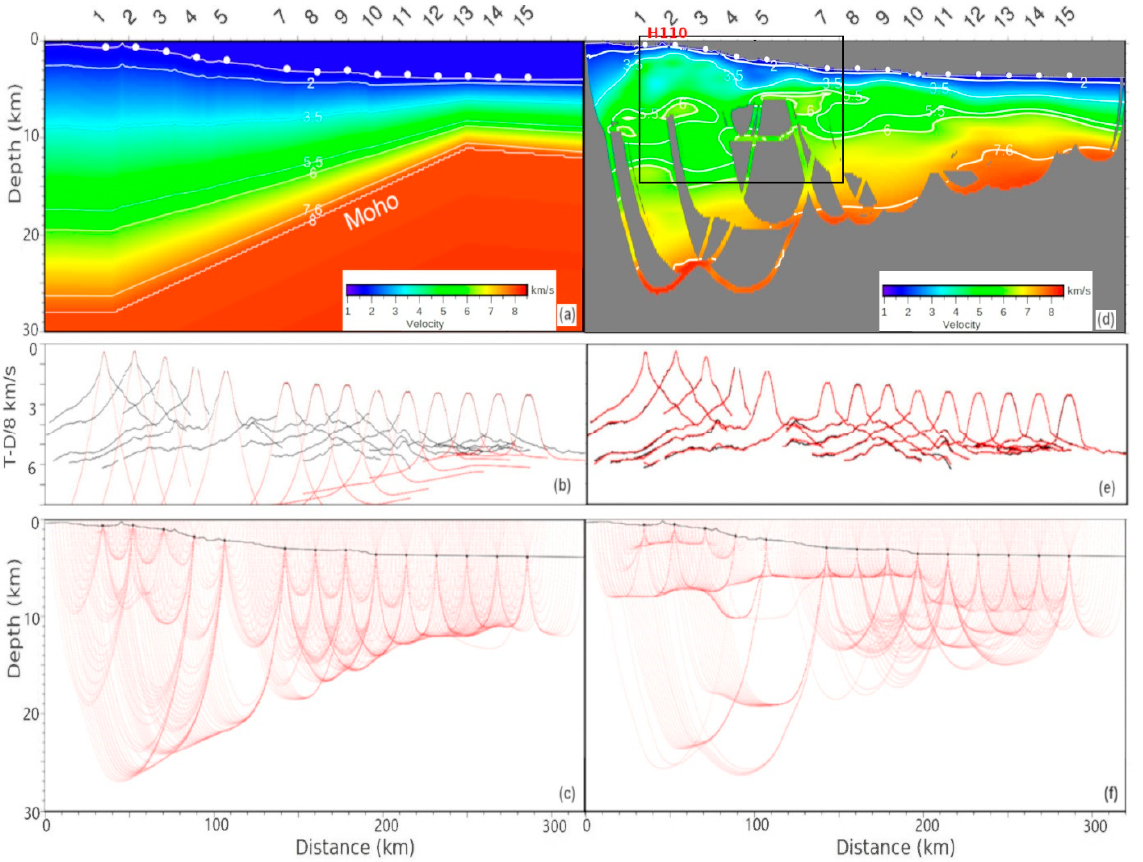
Figure 4. Velocity by iterative inversion. ( a ) an initial velocity model; ( b ) the observed (black dot) and calculated (red line) first arrivals for ( a ); ( c ) ray paths for ( a ); ( d ) inversed model in the 20th iteration; ( e ) observed and calculated first arrivals for ( d ); ( f ) ray paths for ( d ). The box around H110 in ( d ) is shown in Figure 5.